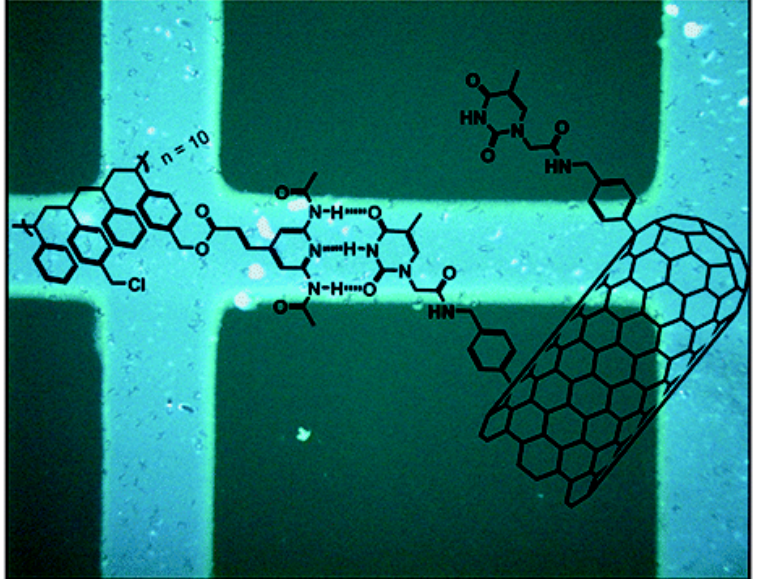
Fig. 16. Chemical structure of the supramolecular polymer MWCNT hybrid complex. Adapted from Ref [83].